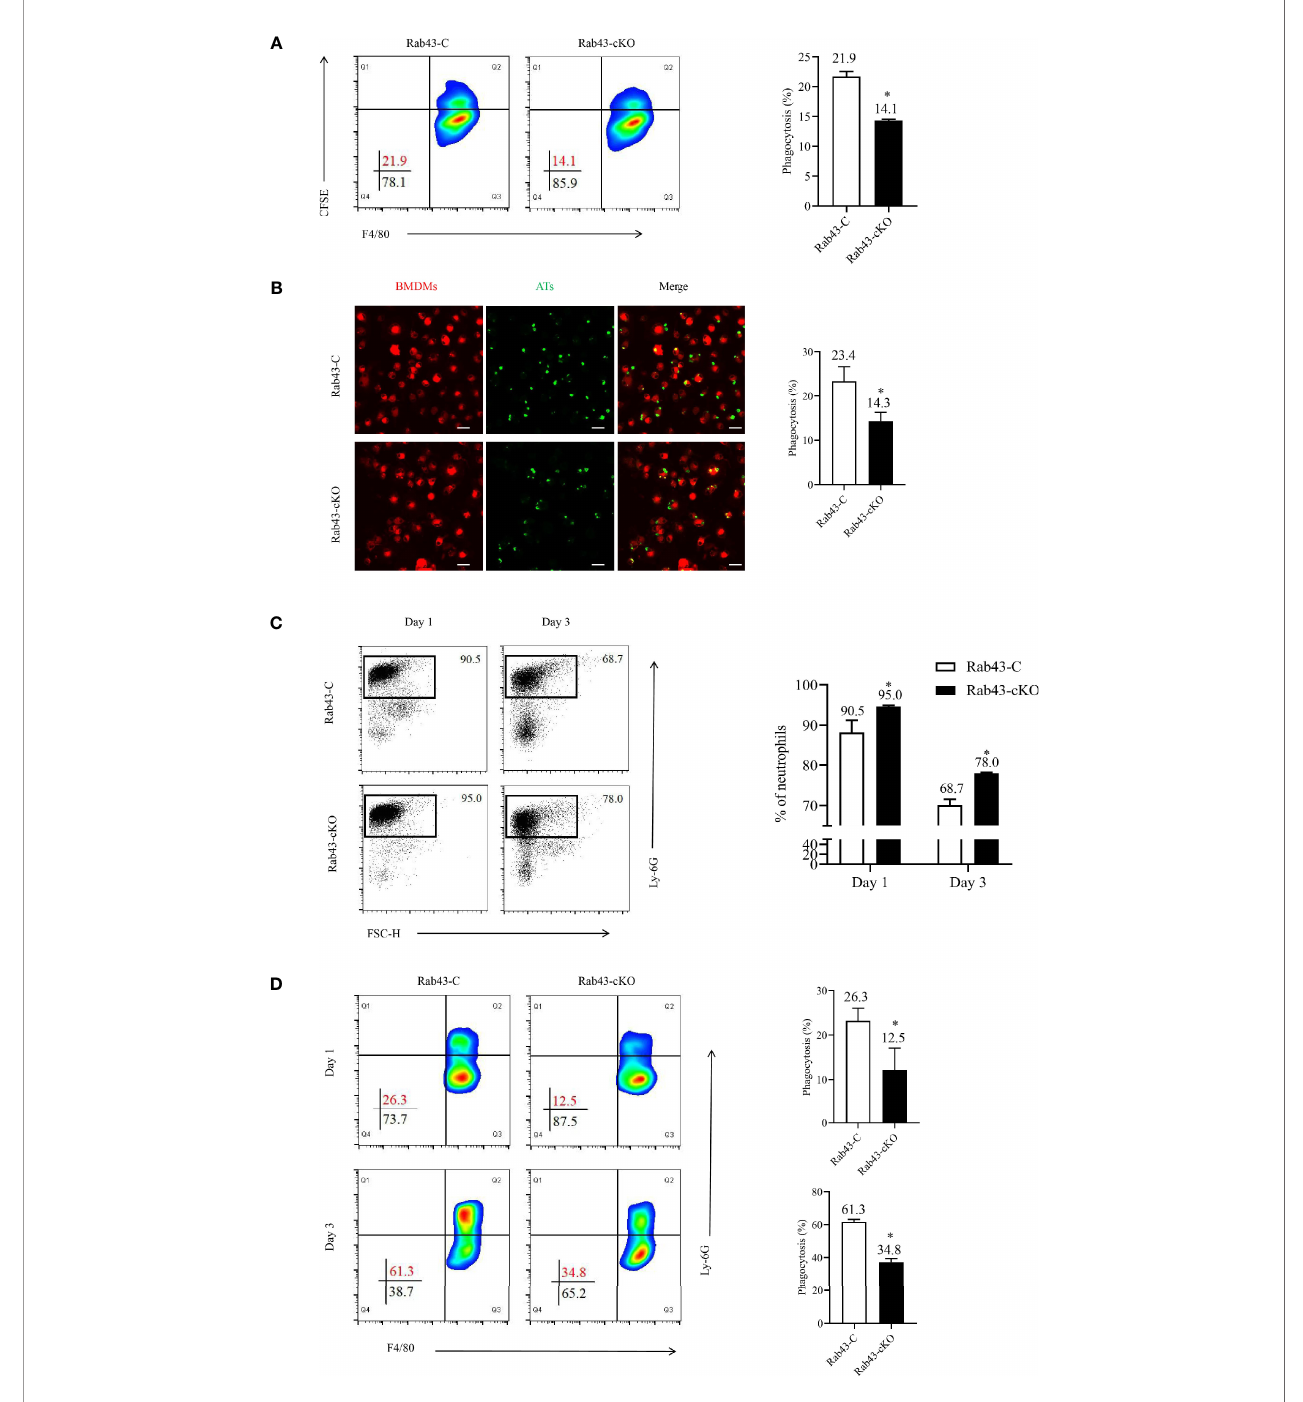
FIGURE 3 | Rab43 de fi ciency impaired efferocytosis by macrophages. (A, B) The efferocytosis by Rab43-C and Rab43-cKO bone marrow-derived macrophages (BMDMs) in vitro analyzed by fl ow cytometry and CLSM. The CFSE-labeled apoptotic thymocytes (Ats) were co-cultured with BMDMs (10:1) for 2 h. The free and attached ATs were removed by extensive washing with cold phosphate-buffered saline (PBS). The engulfed cells were subsequently incubated with anti-F4/80 antibody or Dil Stain. * P < 0.05 versus the Rab43-C group. (C) The percentages of neutrophils in BALF samples detected using fl ow cytometry. The Rab43-C and Rab43-cKO mice were treated (i.t.) with 5 mg/kg lipopolysaccharide (LPS) for 1 and 3 days. The BALF samples were subsequently collected and incubated with anti-Ly6G antibody. (D) Macrophage-mediated efferocytosis in vivo was analyzed using fl ow cytometry. The BALF was collected from Rab43-C and Rab43-cKO mice after treatment with 5 mg/kg LPS (i.t.) for 1 and 3 days. The phagocytosis rate is expressed as the phagocytosis index (PI), which is the number of cells ingested (F4/80+Ly6G+) over the total number of macrophages (F4/80+). * P < 0.05 versus the Rab43-C